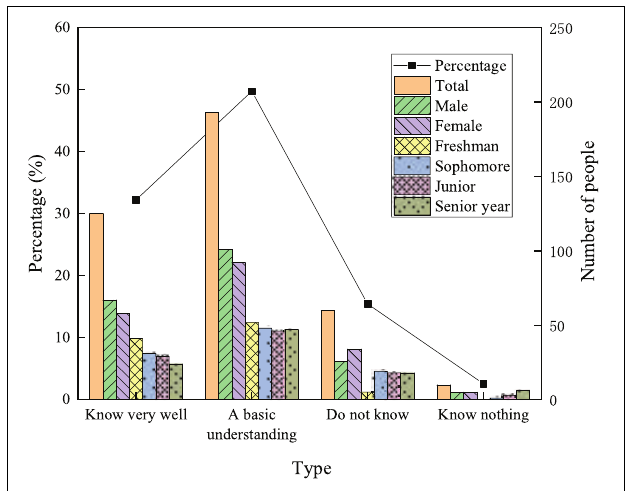
FIGURE 4 | Understanding of network buzzwords of college students.